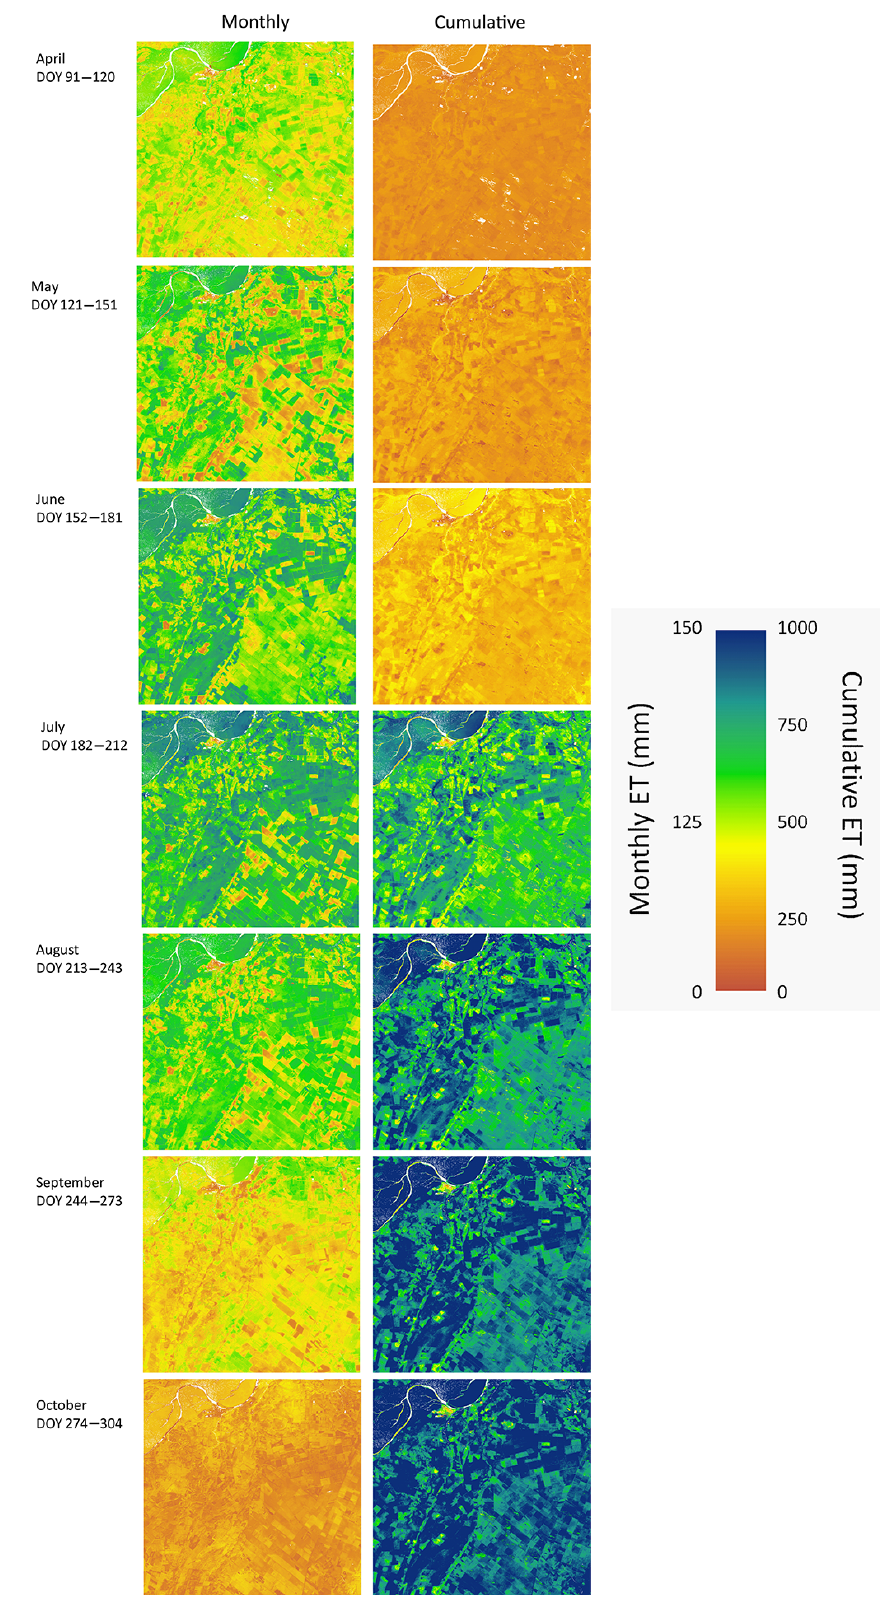
Figure 11. Spatial patterns of monthly cumulative ET (left column panels) from April to October, and cumulative ET on the end day of each month over the study